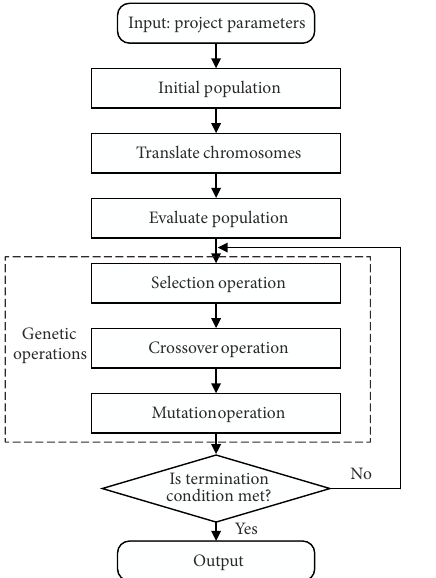
Evaluate population